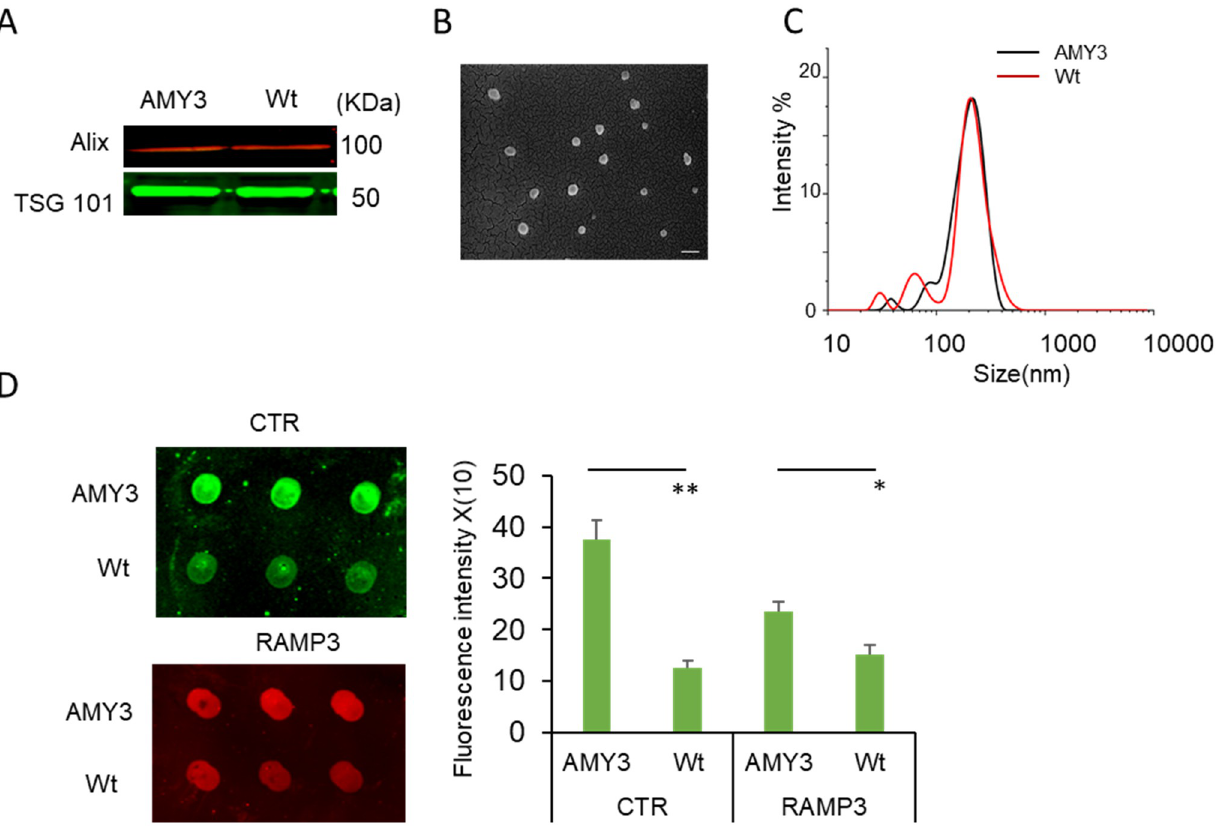
Fig 1. Characterization of extracellular vesicles (EVs) from HEK AMY3 and HEK Wt cells. A , Western blot detection of the Alix and TSG101, two commonly used EV markers. Molecular weights are presented in kDa. B , Transmission electron microscopy of EVs derived from AMY3 cells using a negative staining method. EVs appear as closed vesicles (Scale bar = 200 nm). C , Dynamic light scattering (DLS) showing the relative size of HEKAMY3 and Wt EVs. D . Dot blots (in triplicate from each EV preparation) show amylin receptor heterodimeric components CTR (green) and RAMP3 (red) proteins are more abundant in EVs derived from HEK-AMY3 than HEK Wt cells. Histogram showing the relative quantification of CTR and RAMP3intensity (from dot blots) in AMY3 compared to Wt EVs. Data are presented as mean ± SEM, n = 3, and an average from three independent EV preparations, �� p < 0.01, � p <